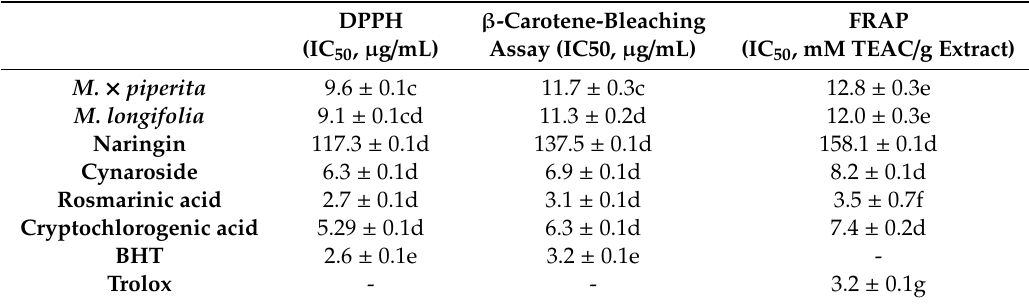
Table 2. 2,2-Diphenyl-1-picrylhydrazyl (DPPH), β -Carotene bleaching, and ferric reducing antioxidant power (FRAP) measurements of M. × piperita and M. longifolia leaf extracts, and naringin, cymaroside, rosmarinic acid, and cryptochlorogenic acid.